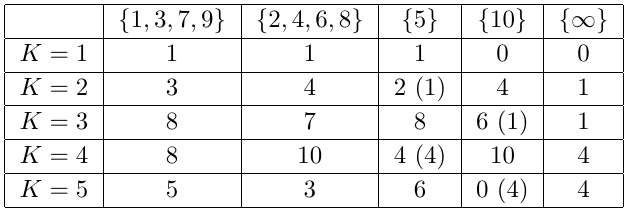
Table 7 . Number of Bethe roots for decomposed BAE with M = 10.